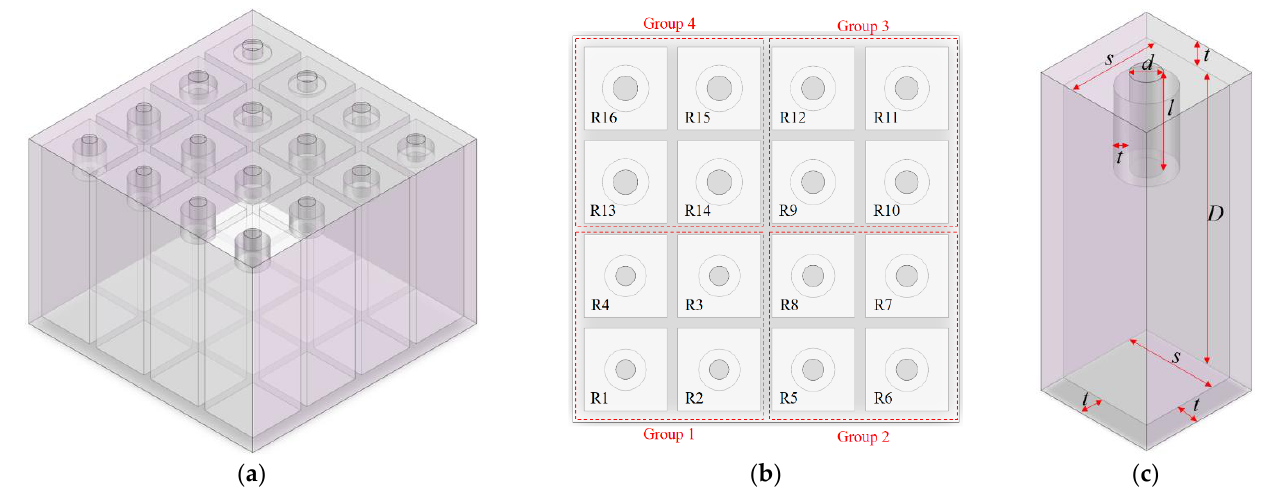
Figure 1. Schematic diagram of the metamaterial cell of the parallel − connection square Helmholtz resonators: ( a ) perspective three − dimensional model; ( b ) divination into groups and numbered resonators: ( a ) perspective three–dimensional model; ( b ) divination into groups and numbered resonators; ( c ) single resonator with marked parameters. resonators; ( c ) single resonator with marked